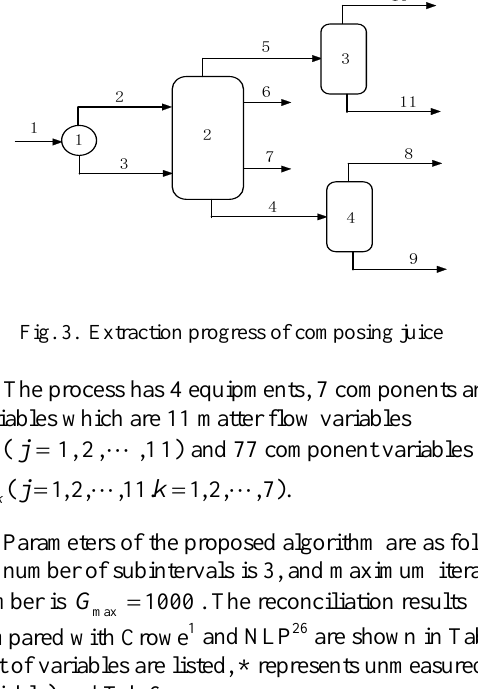
Extraction process of composing juice is shown in Fig.3.